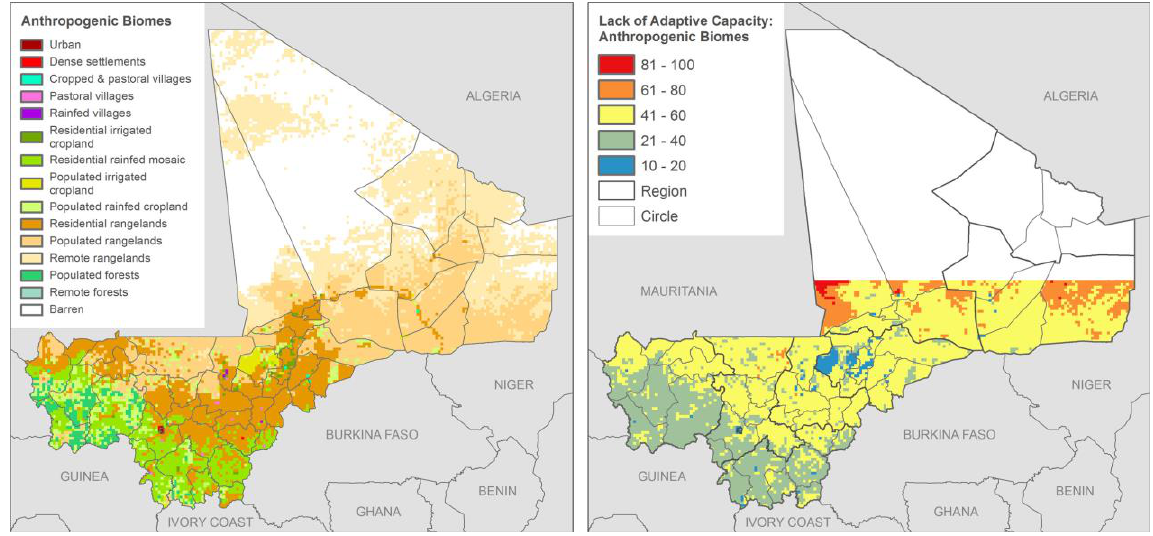
Figure 5. Anthropogenic Biomes raw data ( left ) and transformed ( right